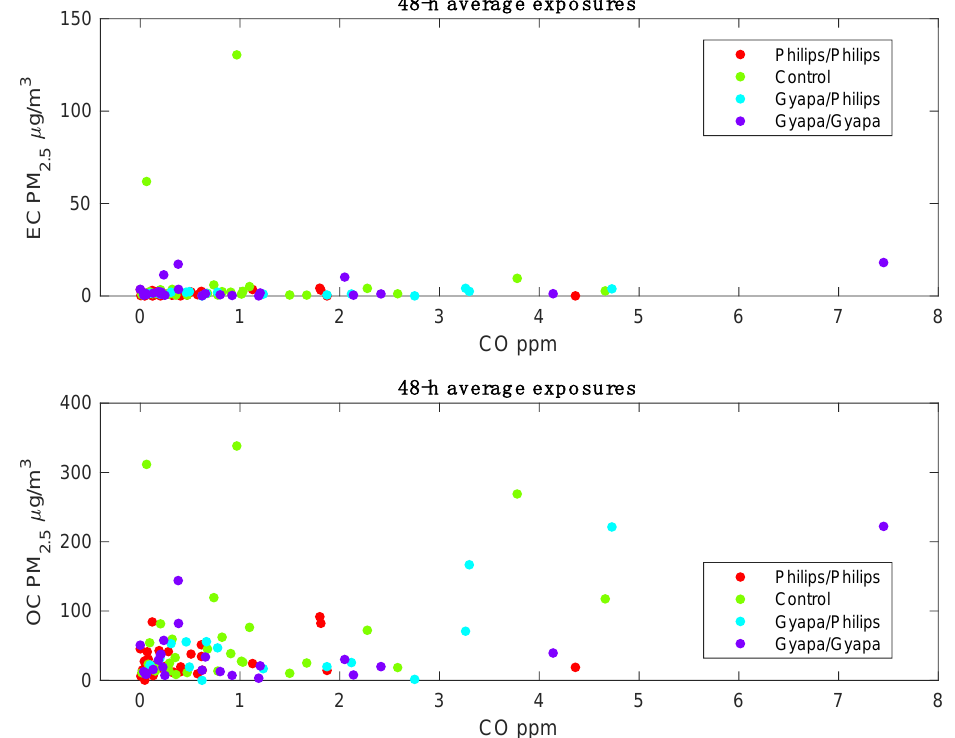
Figure 1. PM 2.5 elemental carbon (EC) and organic carbon (OC) concentration vs. CO personal exposure concentration (48 h averaging) from the dataset with concurrent measurements. Note the lack of correlation between pollutants (R = 0.07 for EC and R = 0.19 for OC), even when accounting for stove group.